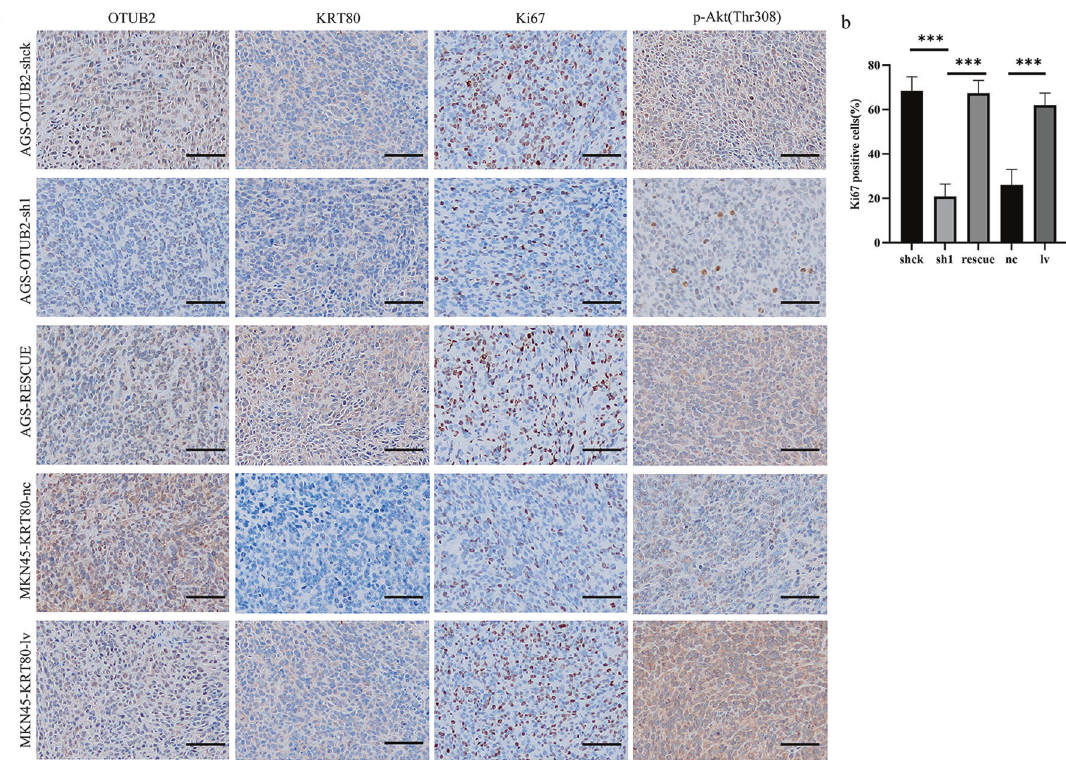
Fig. 7 IHC staining in nude mouse xenograft tumors. a IHC staining of OTUB2, KRT80, Ki67, and p-Akt (Thr308) in nude mouse xenograft tumors derived from AGS-OTUB2-shck cells, AGS-OTUB2-sh1 cells, AGS-RESCUE cells, MKN45-KRT80-nc cells, and MKN45-KRT80-lv cells; scale bar 400 μ m. b Ki67 positive cells quantitative analysis of IHC staining. *** P < 0.001 (Student ’ s t -